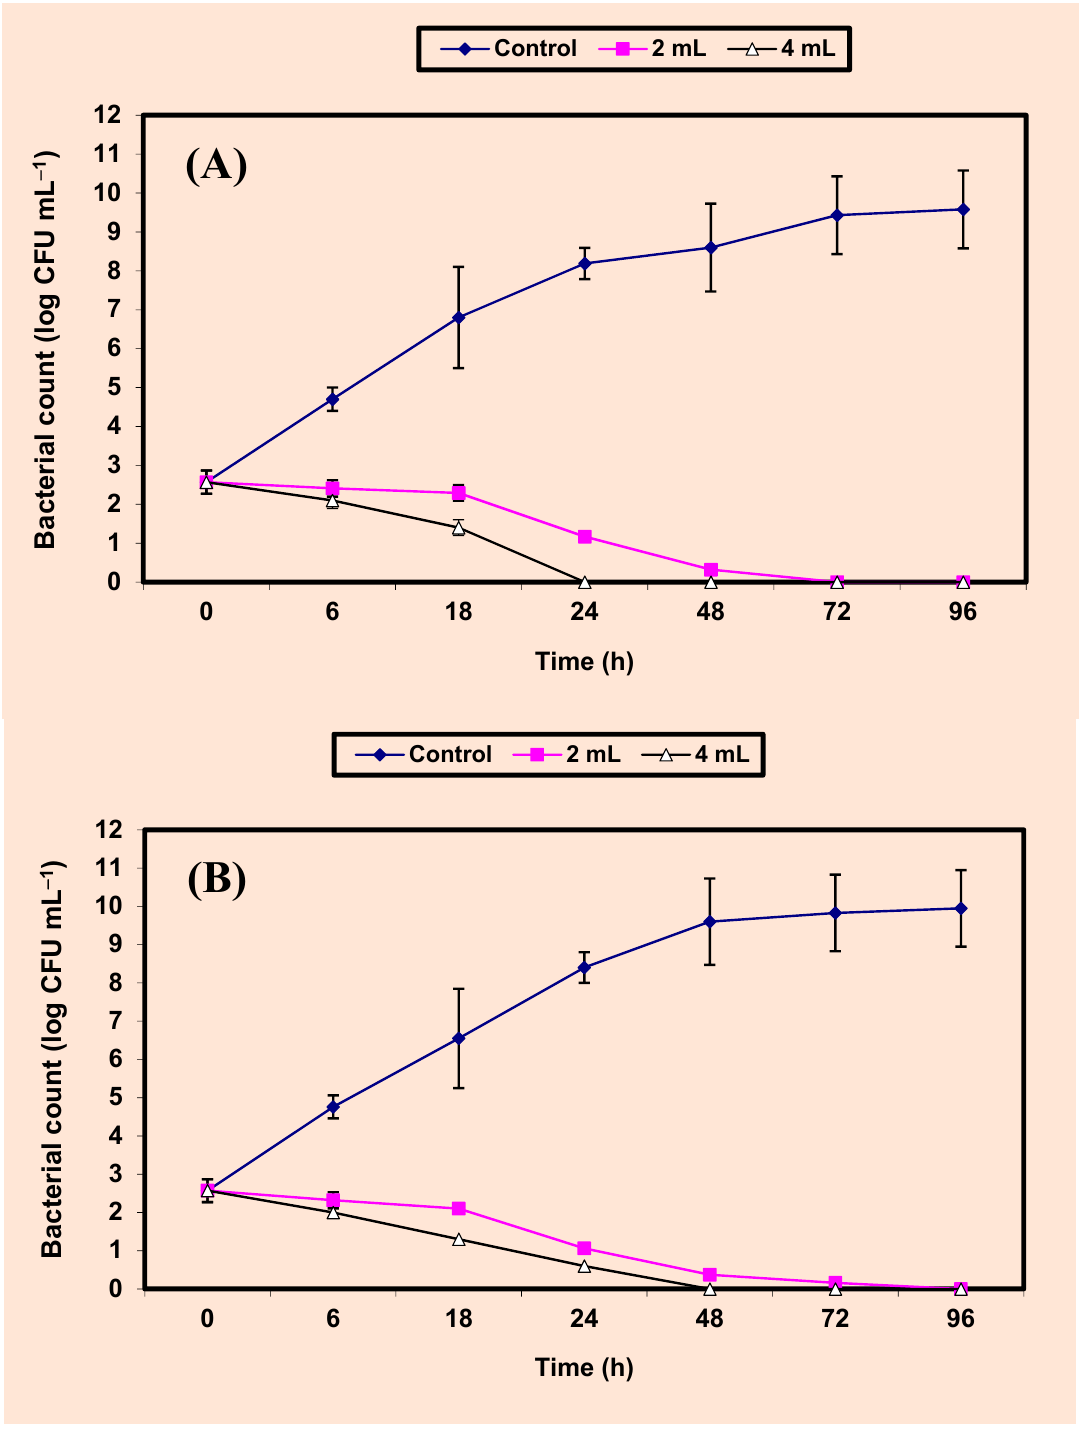
Figure 3. Inhibition of both S. aureus ( A ) and Sal. typhimurium ( B ) in BHI broth. Symbols ♦ , ■ , ∆ refer to control untreated samples, samples treated by 2%, 4% KB, respectively.